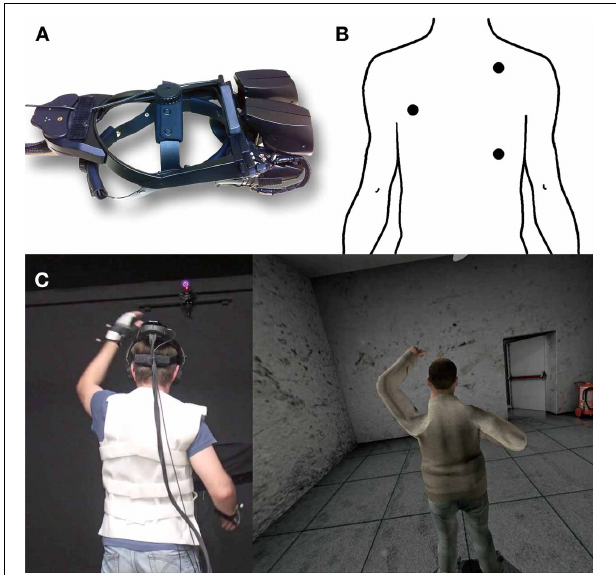
vibrotactile feedback. (C) The skeleton joints position and rotation where updated through HALCA to follow the upper body configuration of